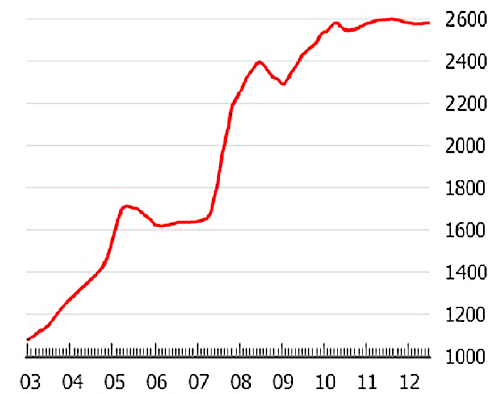
Fig. 3. Second-hand House Price Index, Shanghai (2003 = 1000) Source: http://www.globalpropertyguide.com/real-